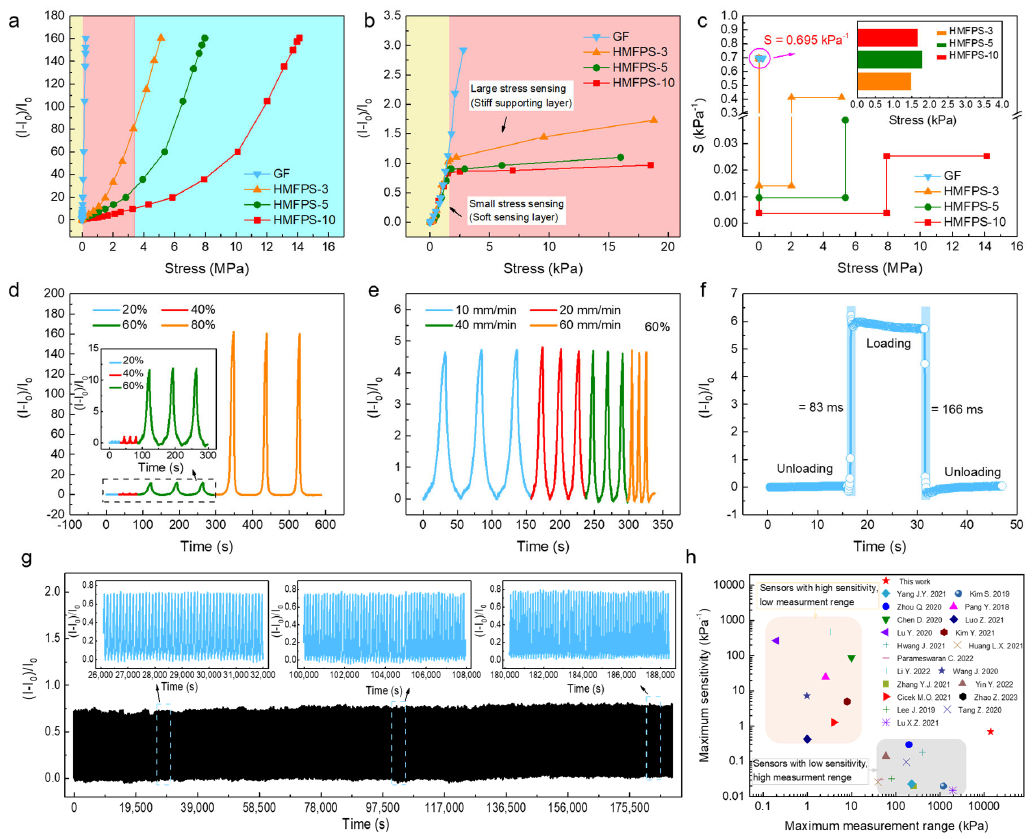
Figure 5. ( a , b ) Current responses of the Gf, HMFPS-3, HMFPS-5, and HMFPS-10; ( c ) Sensitivity and detection range of the Gf, HMFPS-3, HMFPS-5, and HMFPS-10; Current variation rates of the HMFPS-3 to cyclic compression ( d ) from 20% strain to 80% strain and ( e ) to different stress rates; ( f ) Response and recovery time of the HMFPS-3; ( g ) Durability test of the HMFPS over 2000 compression cycles; ( h ) Comparison of this sensor with state-of-the-art counterparts.